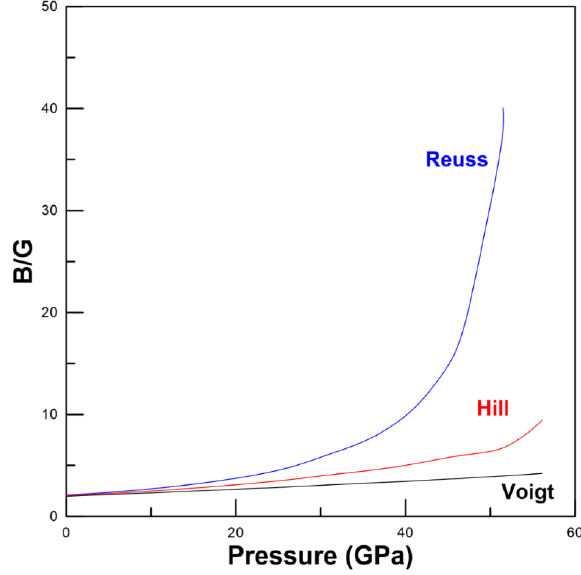
Figure 7. (Color online) Pressure dependence of the B/G ratio.